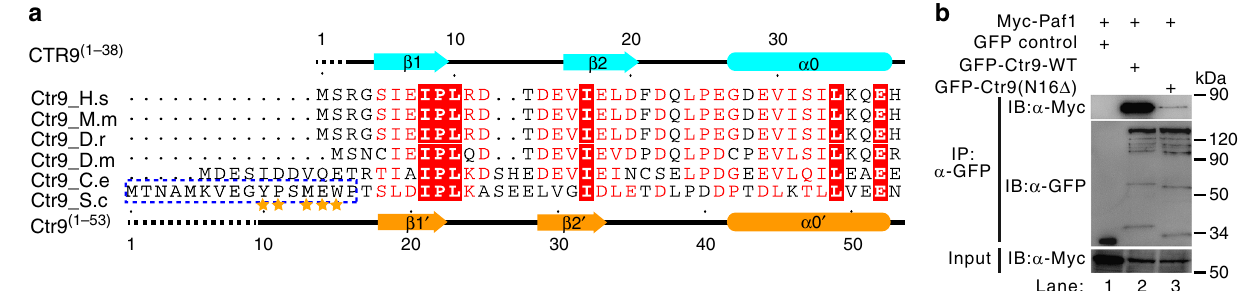
Fig. 5 The longer N-terminal tail of Ctr9 is essential for its binding to Paf1. a Structural-based sequence alignment of the N-terminal fragments of Ctr9 in various species. In this alignment, the secondary structures of human CTR9 (1 – 38) and yeast Ctr9 (1 – 53) are shown at the top and bottom, respectively, and conserved residues are shaded in red. The amino acids 1 – 16 of yeast Ctr9, which were deleted in the GFP-Ctr9(N16 Δ ) construct [used in b ], are marked with a dotted blue box. The amino acids Y10, P11, M13, E14, and W15 of Ctr9 involved in its binding to Paf1 are marked by orange stars. b Co-IP experiments testing the interactions between Ctr9 WT or Ctr9(N16 Δ ) mutant and Paf1. Extracts were prepared from HEK293T cells transfected with various combinations of plasmids, as indicated. The bottom panel shows 3% of the Myc fusion proteins for each IP. Uncropped blots are shown in Supplementary Fig.